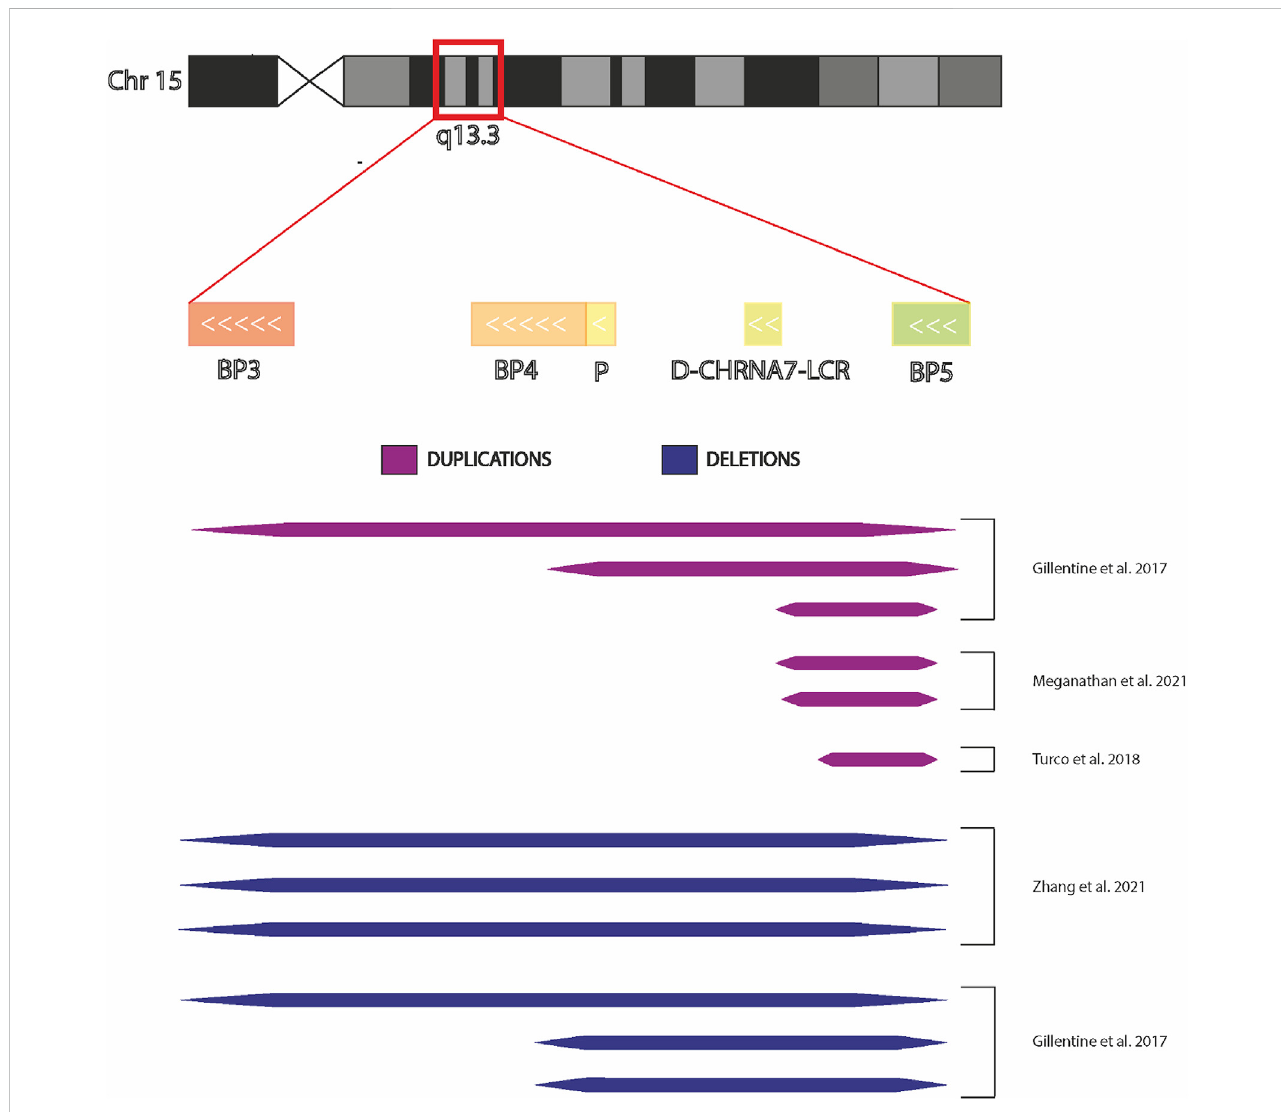
Chromosome 15q13.3 and hiPSCs derived from individuals with CNV. Graphic representation of chromosomal region 15q13.3 showing BreakPoint regions BP3, BP4, and BP5 and the extensions the microdeletions and microduplications present in the hiPSCs in the published